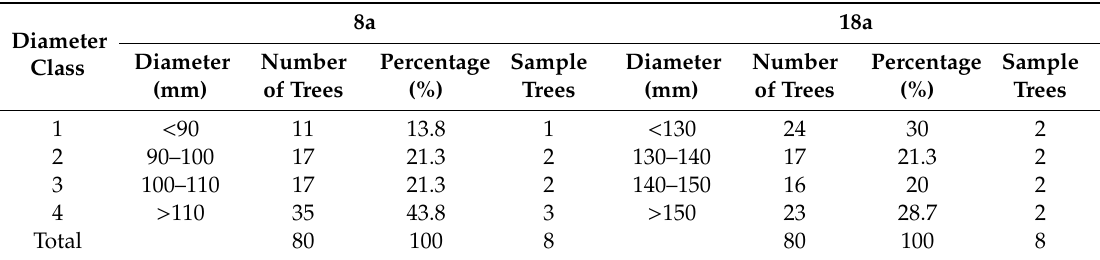
Table 1. Diameters, numbers, and percentages of trees and numbers of sample trees for the sap-flow measurements in the 8- and 18-year-old orchards (8a and 18a,